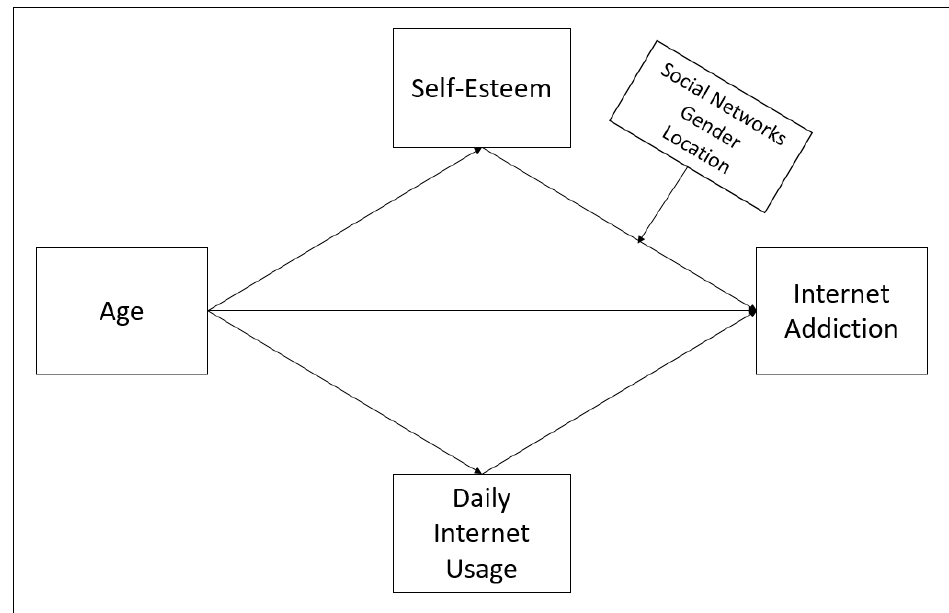
Figure 1. Conceptual model of research.